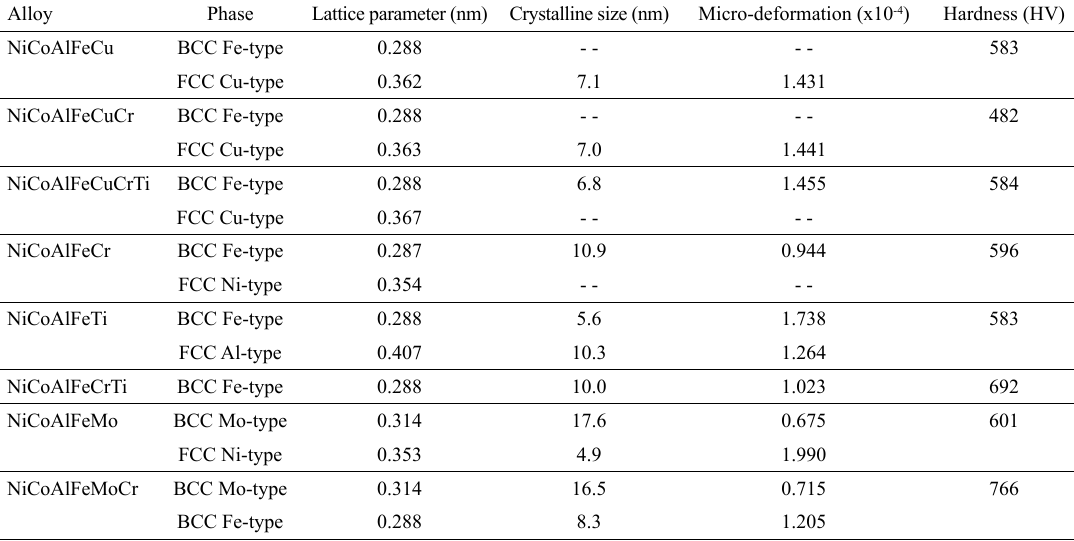
Table 1: Structural characteristics and microhardness of high entropy alloy powders milled for 10 h.